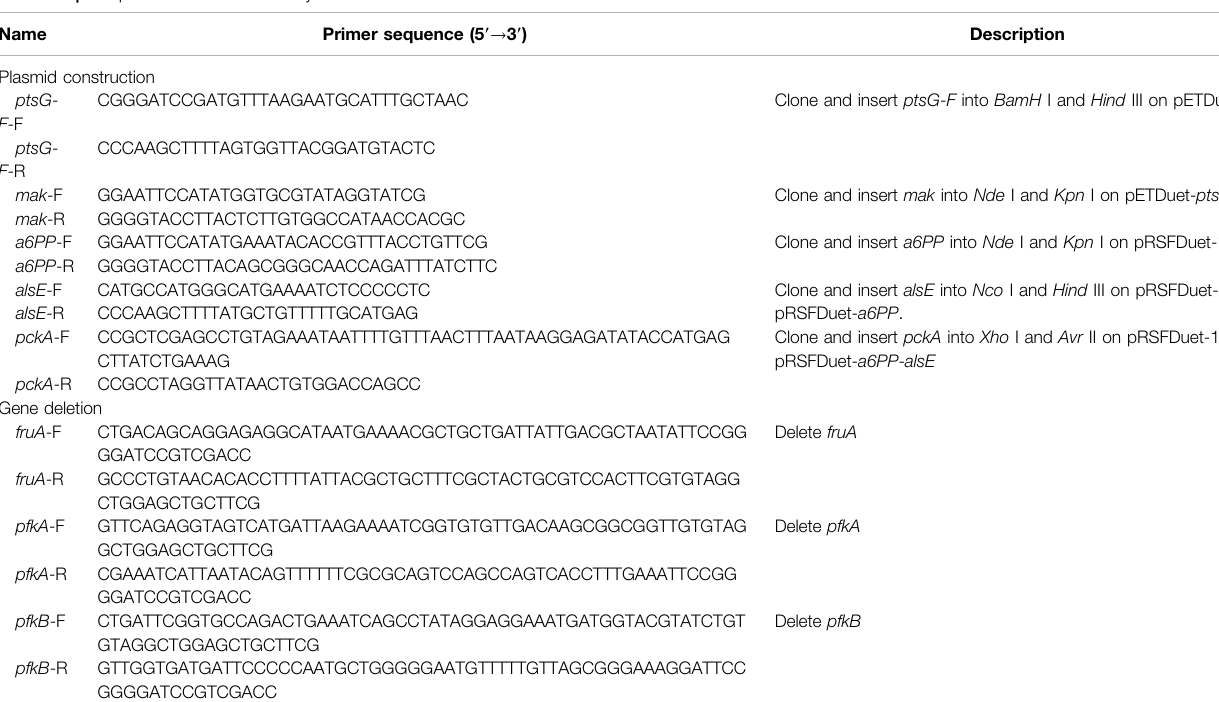
TABLE 2 | The primers used in this